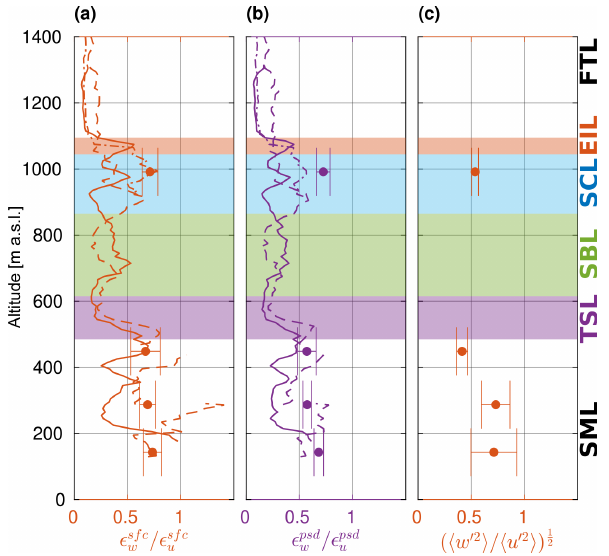
Figure 16. Anisotropy ratios in the decoupled STBL (flight no. 14).